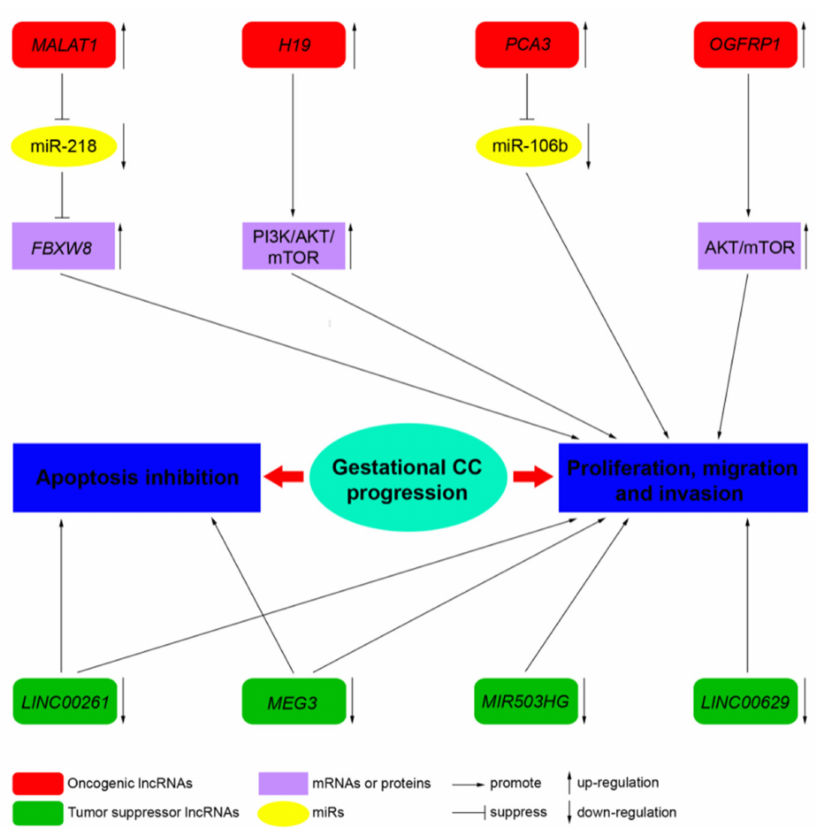
Figure 2. Long non-coding RNAs (lncRNAs) mediate various biological processes to regulate the progression of gestational CC. Certain representative lncRNAs function as oncogenes or tumor suppressors in specific biological processes of gestational